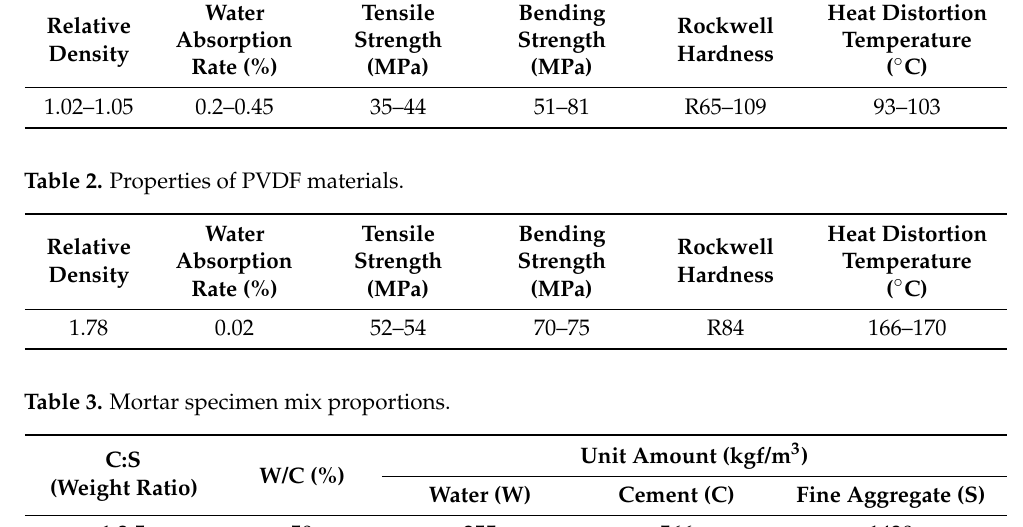
Figure 1. Extraction of ABS (poly acrylic butadiene styrene) and PVDF (poly vinylidene fluoride) powder from discarded membrane. Table 1. Properties of ABS materials.